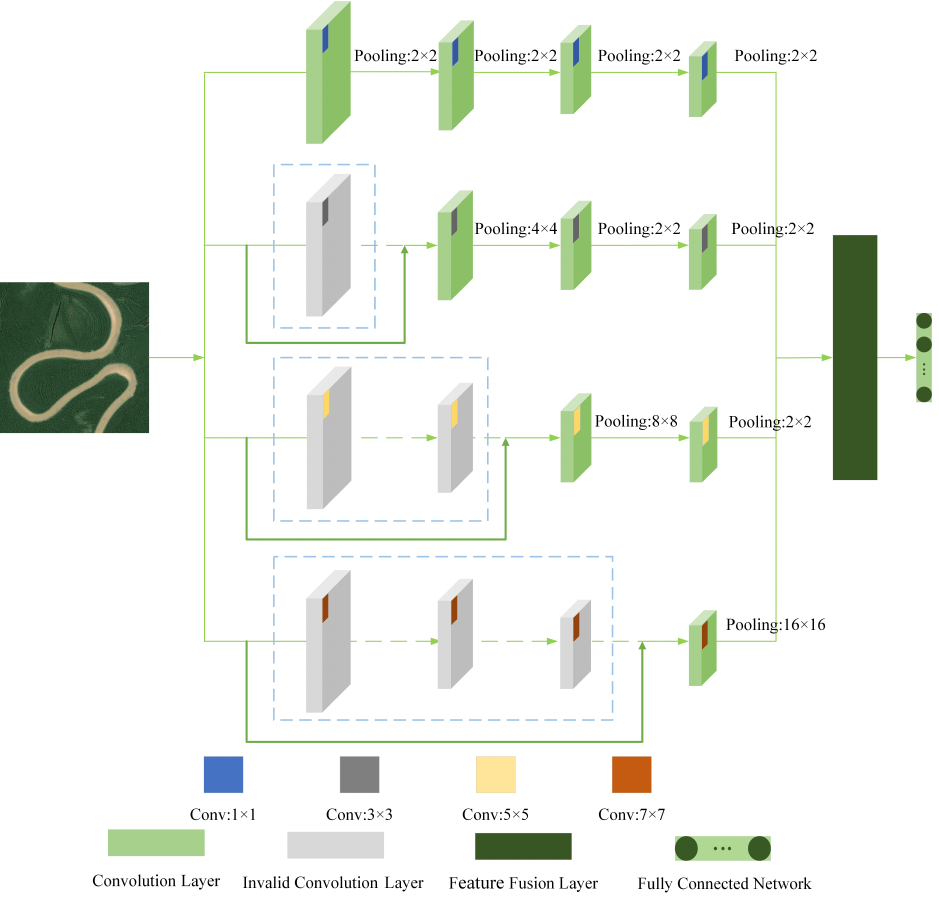
Figure 3. The specific structure of the modified msCNN (mmsCNN)